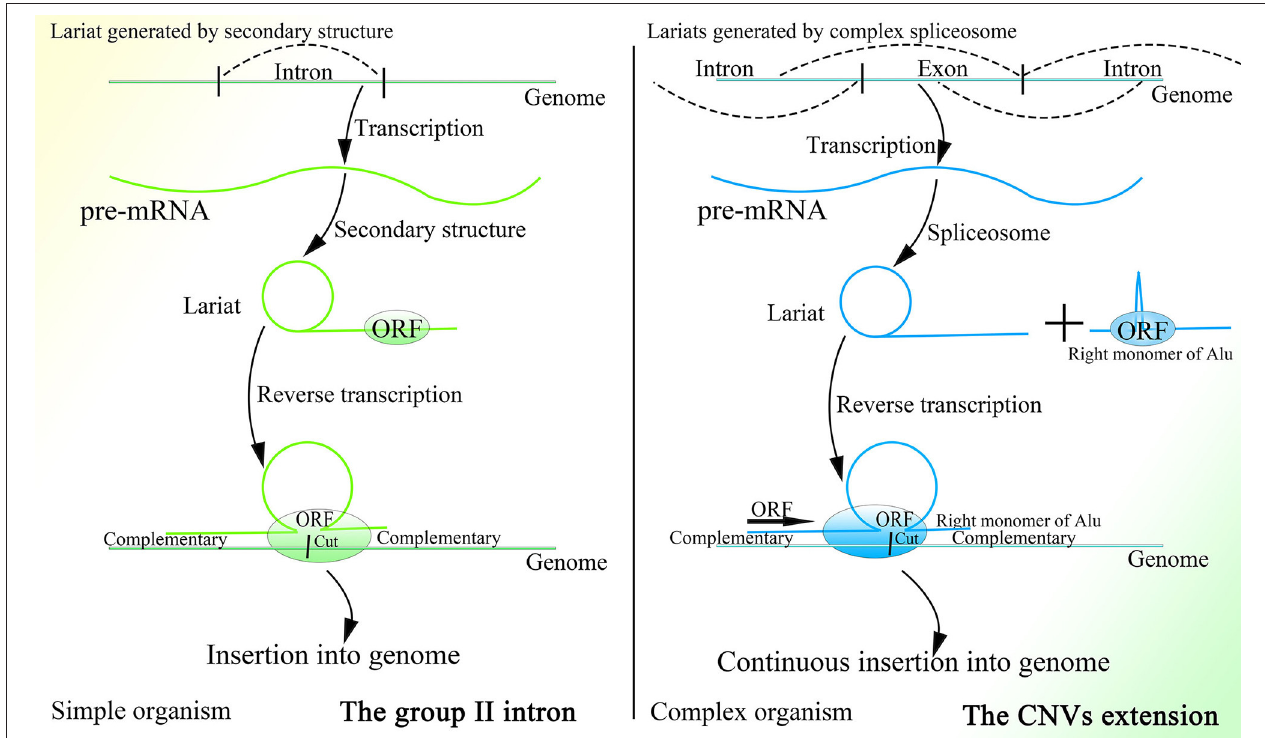
FIGURE 4 | A comparison of the group II intron and the CNV extension mechanism. Given the existence of spliceosomes in complex organisms, the various lariats would be produced without the help of the specific secondary structure, and thus CNV extension brought about by continuous insertion would be